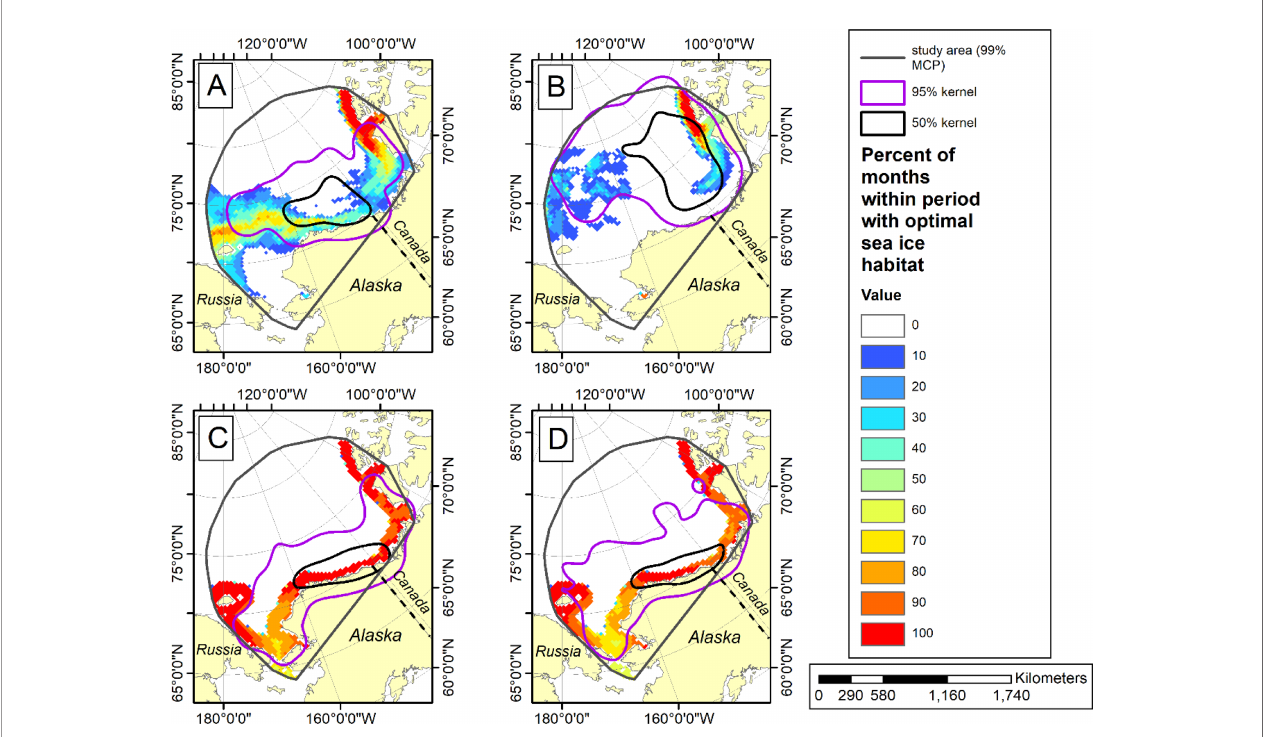
FIGURE 7 | Optimal sea ice habitat (Durner et al., 2019) color-coded by percentage of months with optimal sea ice habitat. The 95% and 50% kernel utilization distributions (contours) show the seasonal distribution of adult female polar bears instrumented with satellite-linked collars in the Southern Beaufort Sea during minimum (summer) and maximum (winter) ice extent for two periods (1985-1995 and 2007-2016). (A) summer ice extent season for 1985-1995 and (B) for 2007- 2016; (C) winter ice extent season for 1985-1995 and (D) for 2007-2016. For details see Durner et al.